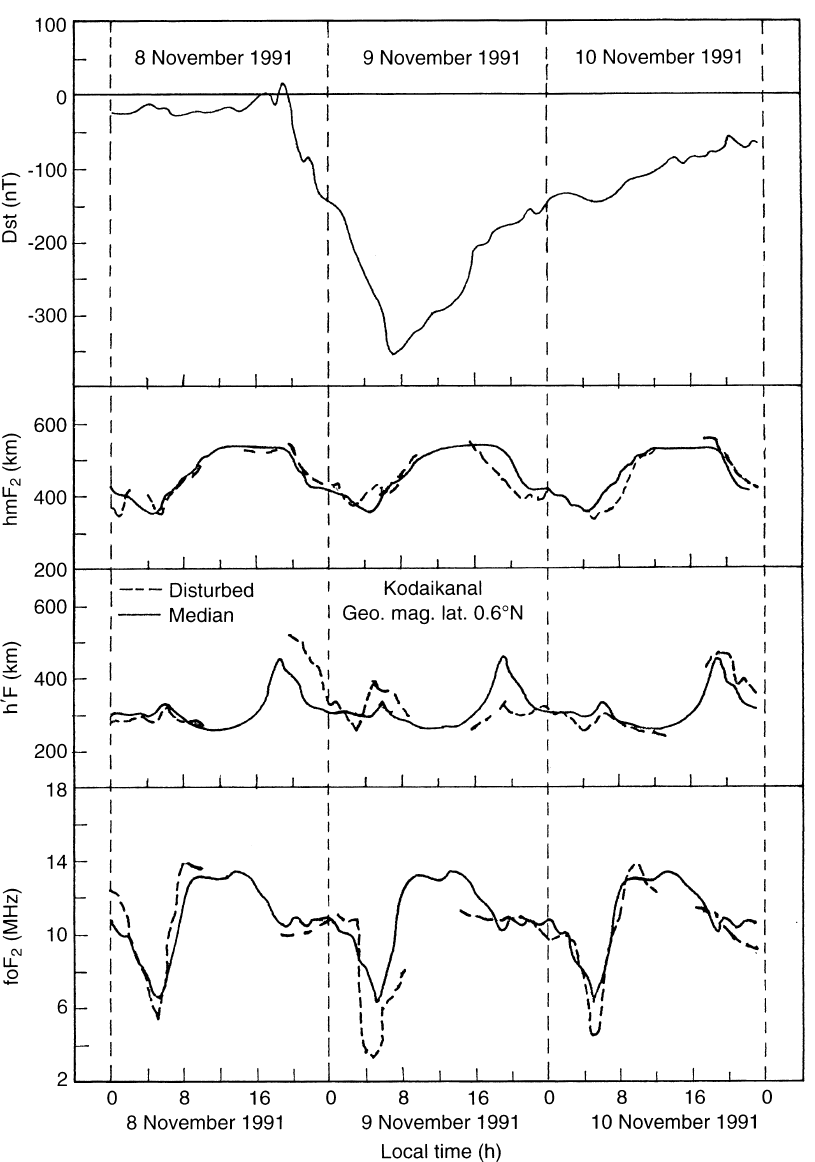
Fig. 3. Shows foF2, h ¢ F and hmF2 data for Kodaikanal for the 8 November 1991 storm along with respective monthly median values. Dst variation for the storm period is shown in the top